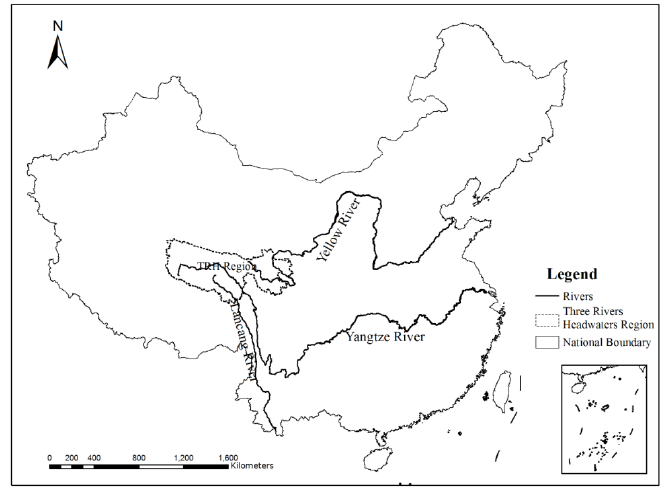
Figure 1. Location of Three Rivers Headwaters Region, Qinghai,